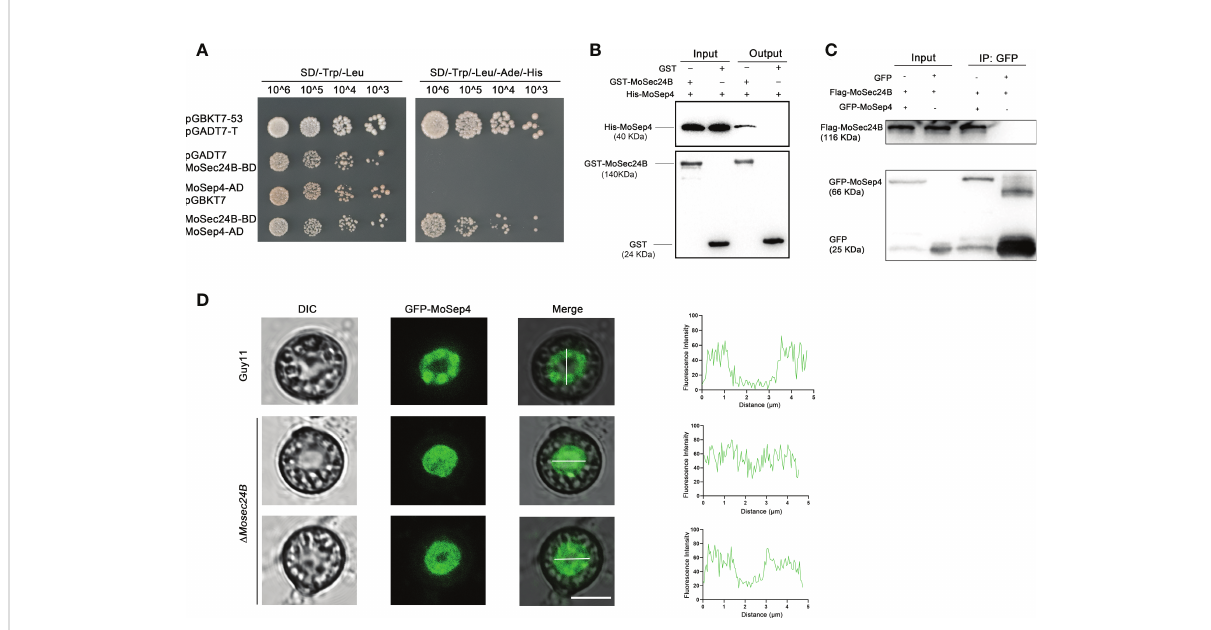
FIGURE 7 (A) Interaction between MoSec24B and MoSep4 was detected using a yeast-two-hybrid assay. (B) Interaction between MoSec24B and MoSep4 was examined using a pull-down assay. (C) Interaction between MoSec24B and MoSep4 was detected using a co-IP assay. (D) Subcellular localization of MoSep4 in the wild-type and D Mosec24B mutant appressoria (Fv3000, 60 × oil). Scale Bar = 5 m